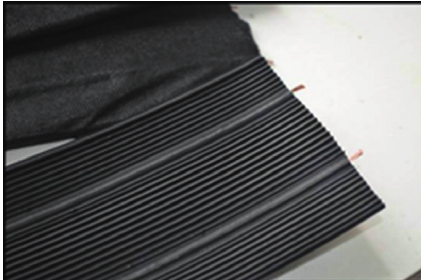
Figure 2: Photograph of the tabular EKG. Table 2: Basic parameters of the laboratory